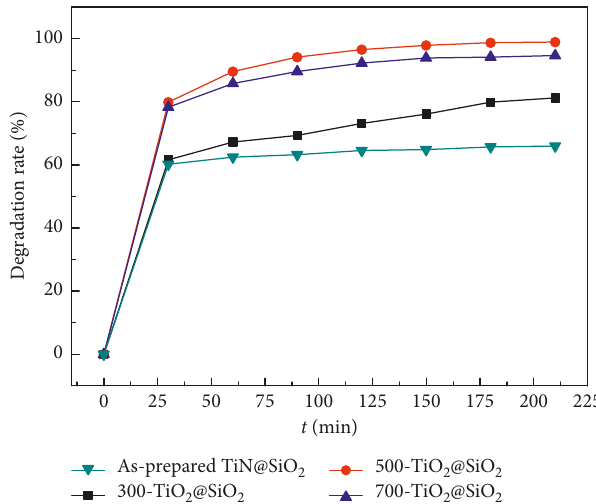
Figure 3: Adsorption/photocatalytic degradation rate curves of TiO 2 − x N x @SiO 2 composite aerogels for RhB under visible light irradiation.